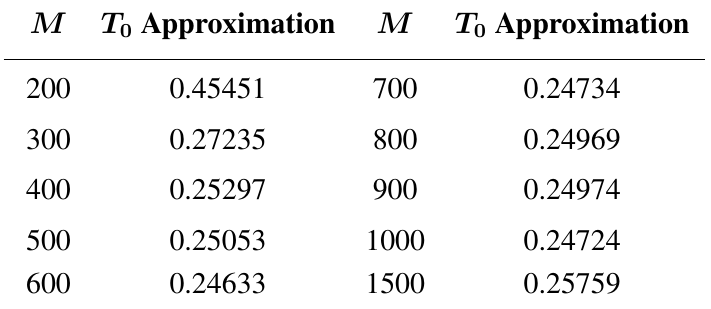
in the four-pole example using extrapolation. The exact 0 = 0 . 24805 0